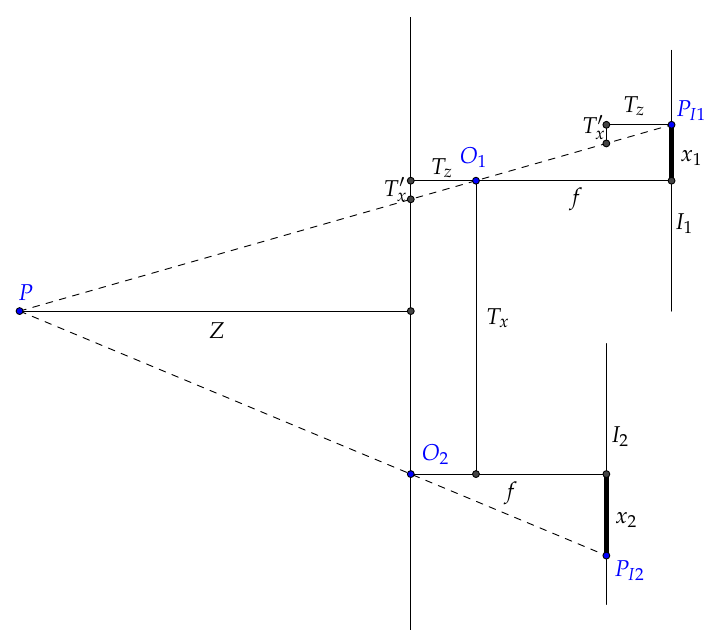
Figure 2. Adapted stereo schematics for 2D motion. The figure illustrates a point P projected on two different images, denoted by points P I 1 and P I 2 . Z stands for the depth, f for the focal length, T x and T z for translations, x 1 and x 2 the distances from the projected points to the principal point and T (cid:48) x a projected compliment of the translation along the x